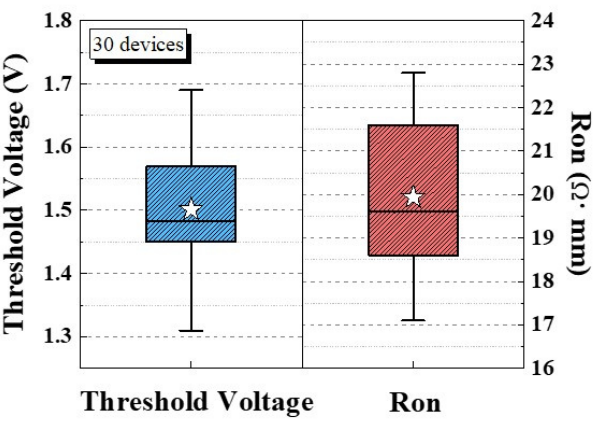
Figure 8. V TH and Ron distributions for 30 devices.